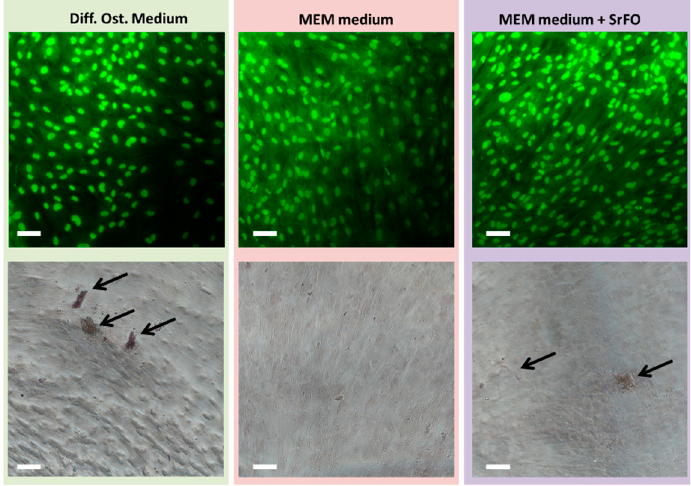
Figure 3. Alkaline phosphatase (ALP) expression in human osteoblasts cultured in the presence of Sr and Ca folic acid derivatives. Figure adapted from Rojo et al. [18] with permission from the Royal society for Chemistry.